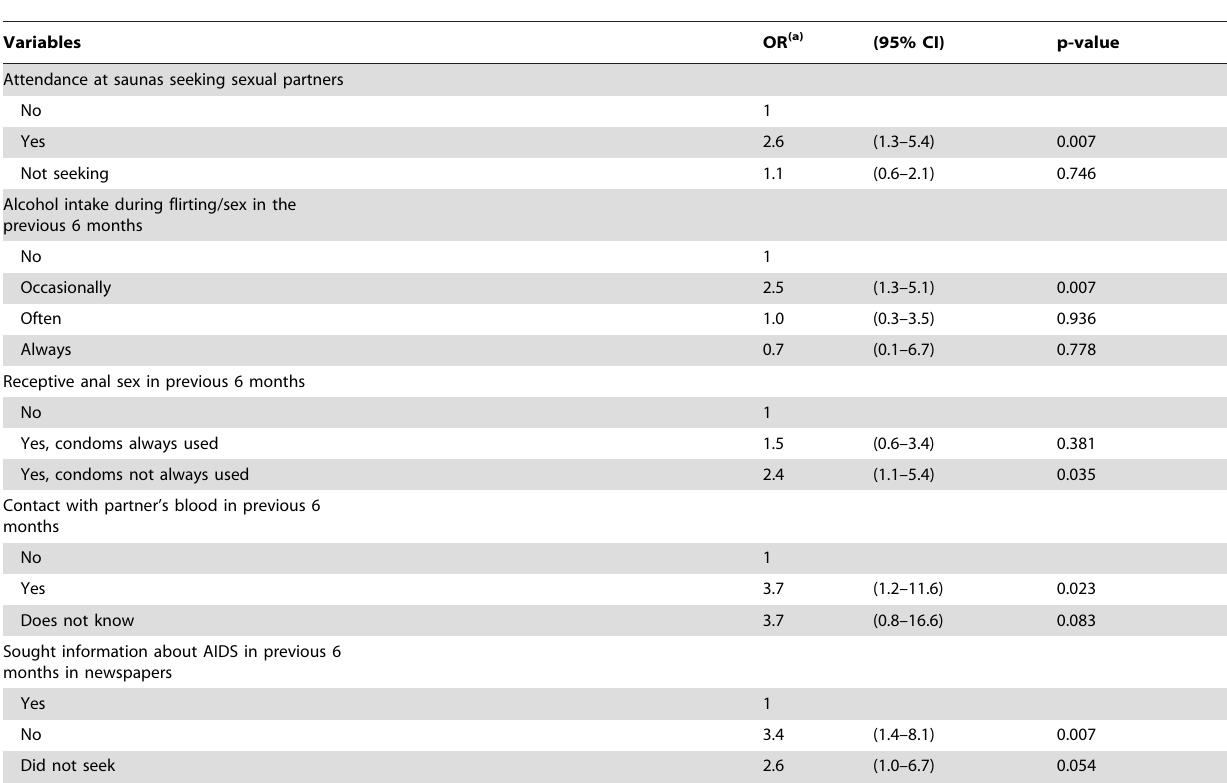
Table 4. Final conditional logistic regression model: HIV risk factors among MSM, Project Horizonte, 1994–2010.